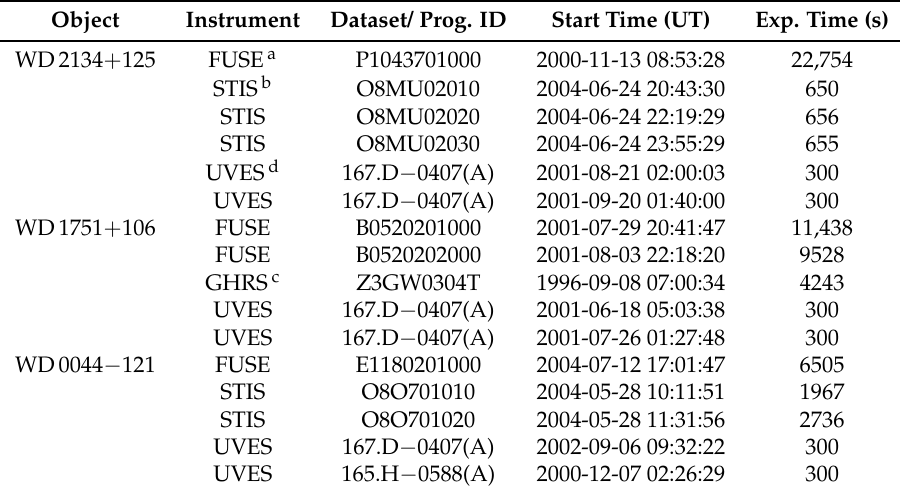
Table 1. Observation log for WD2134 + 125, WD1751 + 106, and WD0044 − 121.